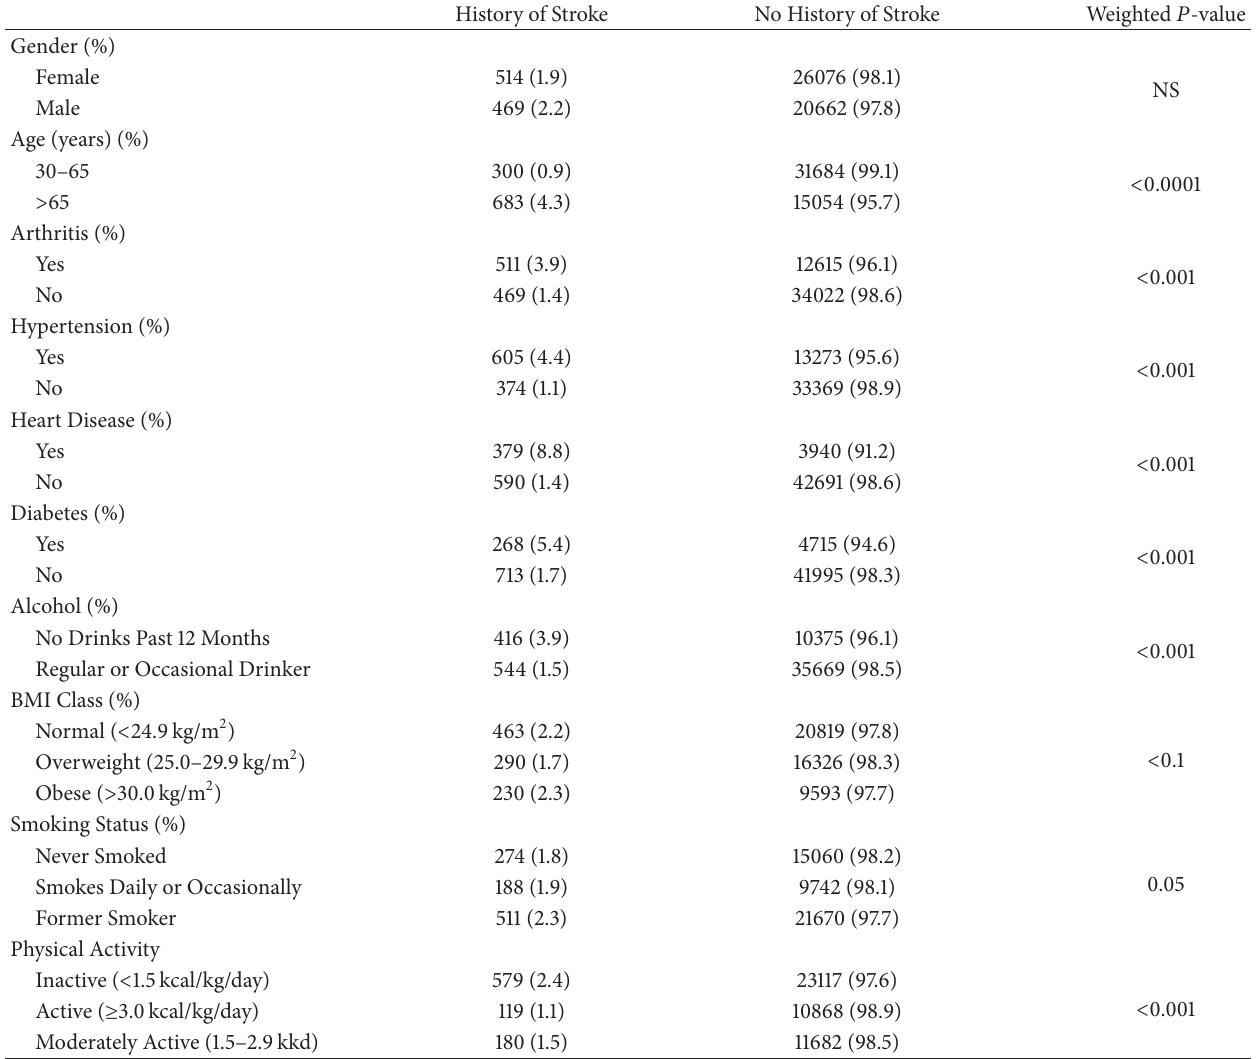
Table 1: Baseline variables compared by stroke